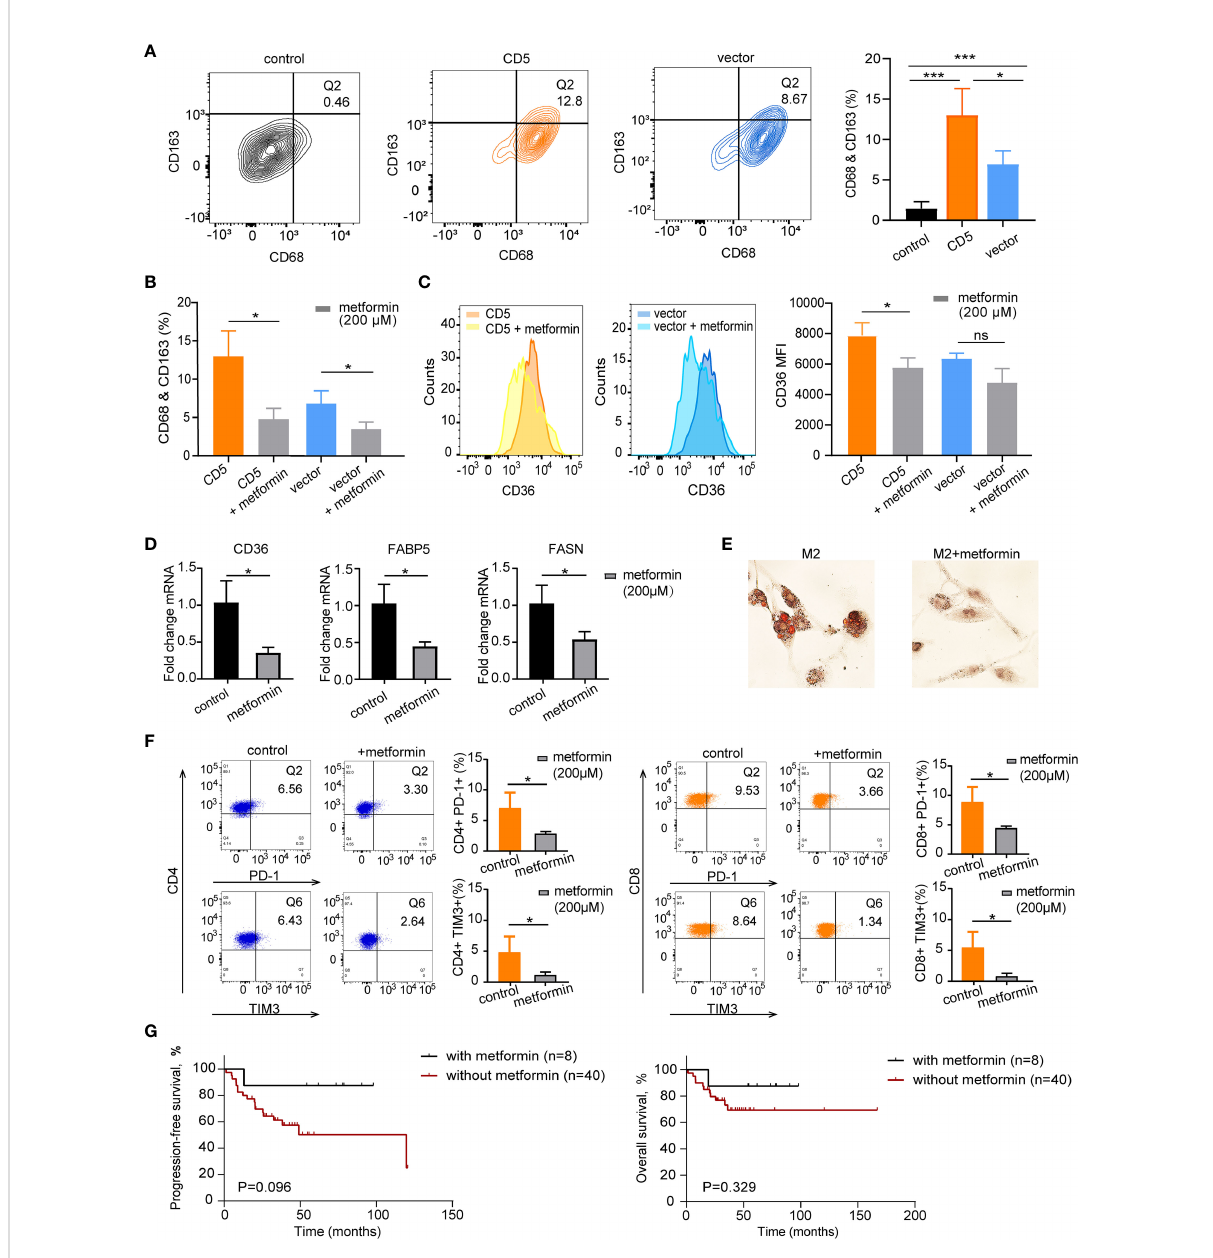
FIGURE 5 The therapeutic impacts of metformin on M2 lipid metabolism and CD36 expression. (A) Flow cytometry analysis of M2 macrophages (Q2) proportion based on co-expression of CD68 and CD163 in PBMC control, coculture of PBMC and LY-10/CD5, and coculture of PBMC and LY- 10/vector for 72 h (B) Bar plot of M2 proportion in PBMC cocultured with LY-10/CD5 or LY-10/vector with or without 200 m M metformin treatment for 72 h, summarized as mean ± SD (n = 3). (C) Flow cytometry analysis of CD36 expression on M2 macrophages comparing the counts and median fl uorescence intensity (MFI) of CD36 on M2 in PBMC cocultured with LY-10/CD5 or LY-10/vector with or without 200 m M metformin treatment. (D) The normalized mRNA expression of CD36, FABP5, and FASN in THP-1 – induced M2 cells with or without 200 m M metformin treatment. (E) Oil red O staining of lipid droplets in THP-1 – induced M2 cells with or without 200 m M metformin treatment. (F) Expression of immune checkpoint PD-1 and TIM3 on CD4 and CD8 T cells after LY-10/CD5 cocultured with PBMC with or without 200 m M metformin treatment for 72 h (G) Kaplan – Meier survival curves of PFS and OS in CD5+ non-DE patients with (n = 8) or without (n = 40) metformin maintenance. * represented signi fi cant difference of